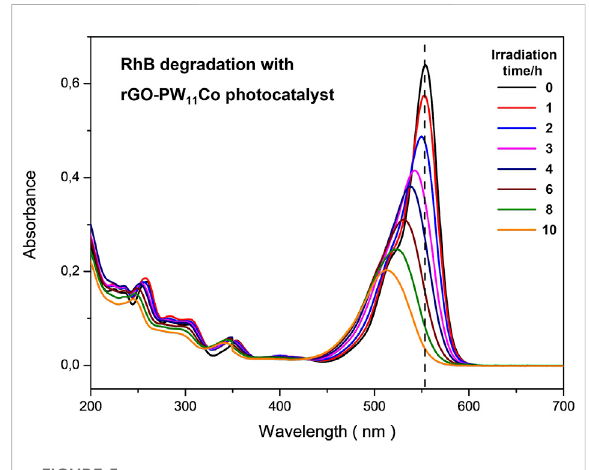
FIGURE 5 Absorption spectra recorded during the photocatalytic degradationof Rhodamine B (10 ppm) in thepresence of 14 mg of rGO-PW 11 Co under irradiation of a 400 W halogen